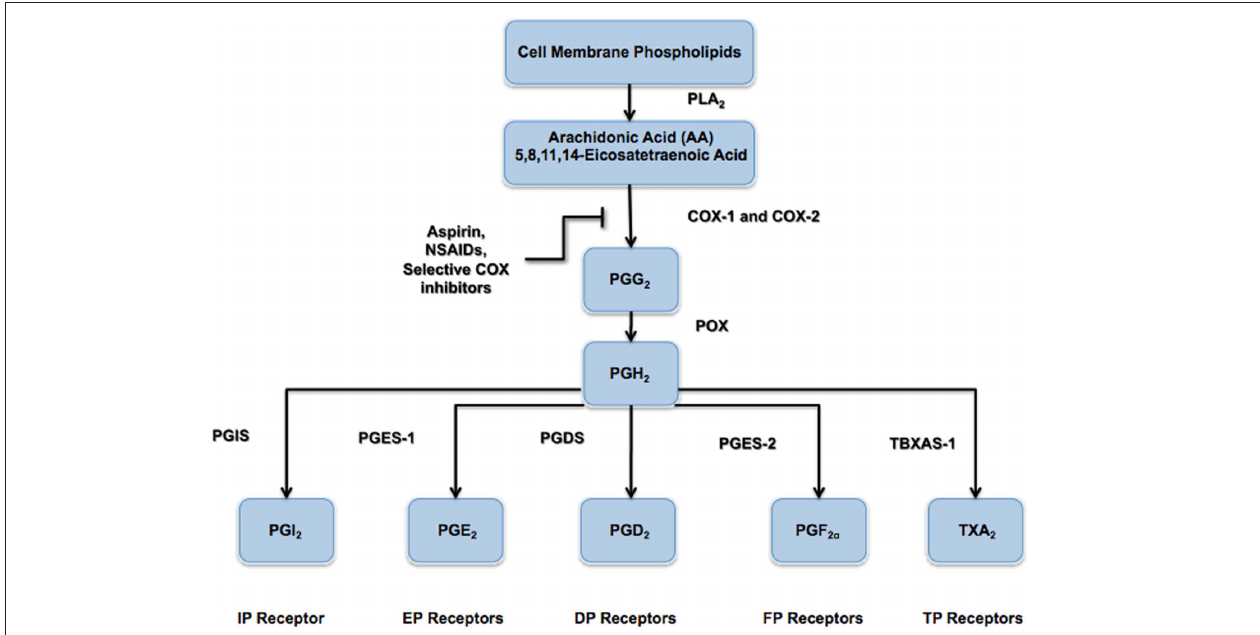
enzyme, which releases a single oxygen (O prostanoids are derived from the parent compound PGH via their respective synthase enzymes, namely prostaglandin I (PGIS), prostaglandin ) molecules. 2